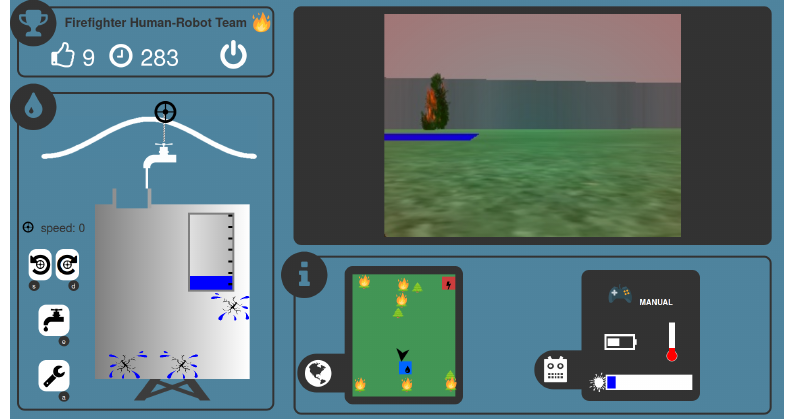
Figure 1. Screenshot of the graphical user interface (GUI) during a mission. Top left : remaining time and score. Top right : robot camera feedback. Bottom left : water stock management task. Bottom right : robot